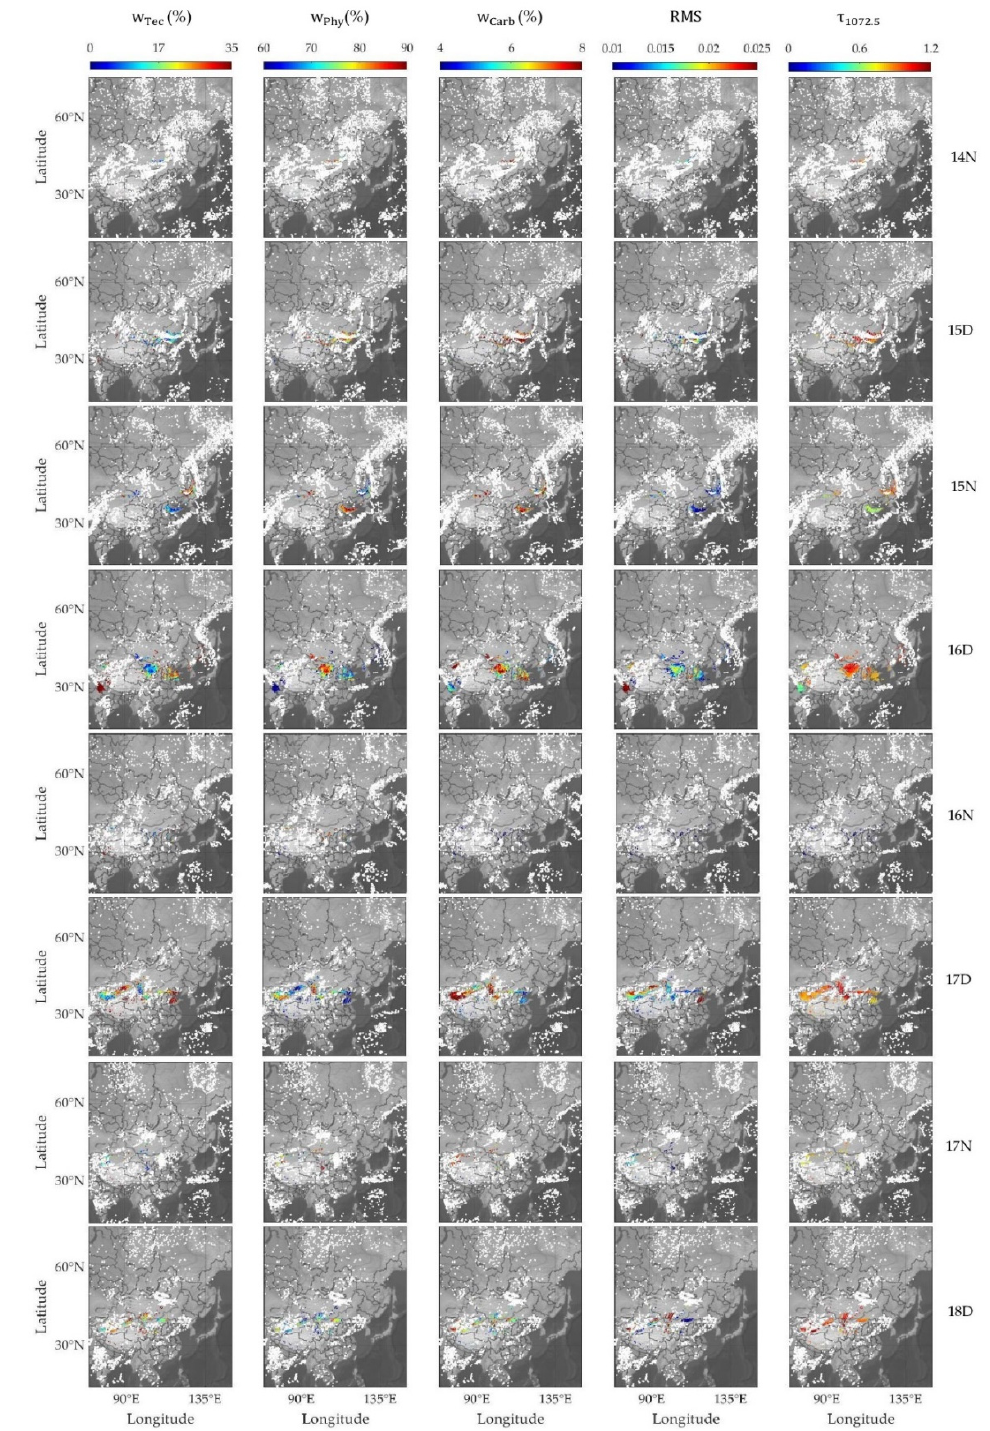
Figure 17. Mineralogical mass weight maps of tectosilicates, phyllosilicates, and carbonates during the 14–18 March 2021 dust storm by day (D) and night (N) from IASI detections. First, on 15 March, dust mass III was a mixture of the Gobi and Horqin sources, with high tectosilicate content. This agrees with the results obtained in May 2017, with the Horqin Sandy Land source causing the increase in tectosilicate weight. This can be compared to dust mass II, presenting lower tectosilicate content as it originated only from the Gobi Desert. In addition, the weight of phyllosilicates was higher in II compared to